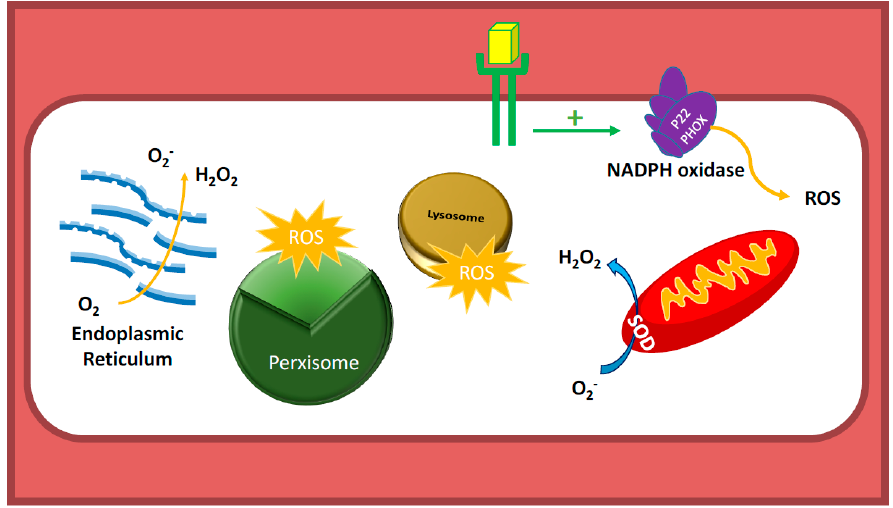
Figure 1. Sources of reactive oxygen species (ROS) in endothelial cells (EC). Nicotinamide Adenine Dinucleotide Phosphate (NADPH) oxidases are the major sources of ROS in ECs. Unlike in other cell types, mitochondria, which constitute only 5% of endothelial cell mass, are not believed to be major sources of ROS, as ECs do not depend on mitochondrial oxidative phosphorylation as their energy source. ECs, like tumor cells, utilize glycolysis as their source for Adenosine triphosphate (ATP) generation. Peroxisome, lysosome, and Endoplasmic Reticulum (ER) also produce ROS in EC. SOD: superoxide dismutase; P22 PHOX: P22 Phagocyte Oxidase.